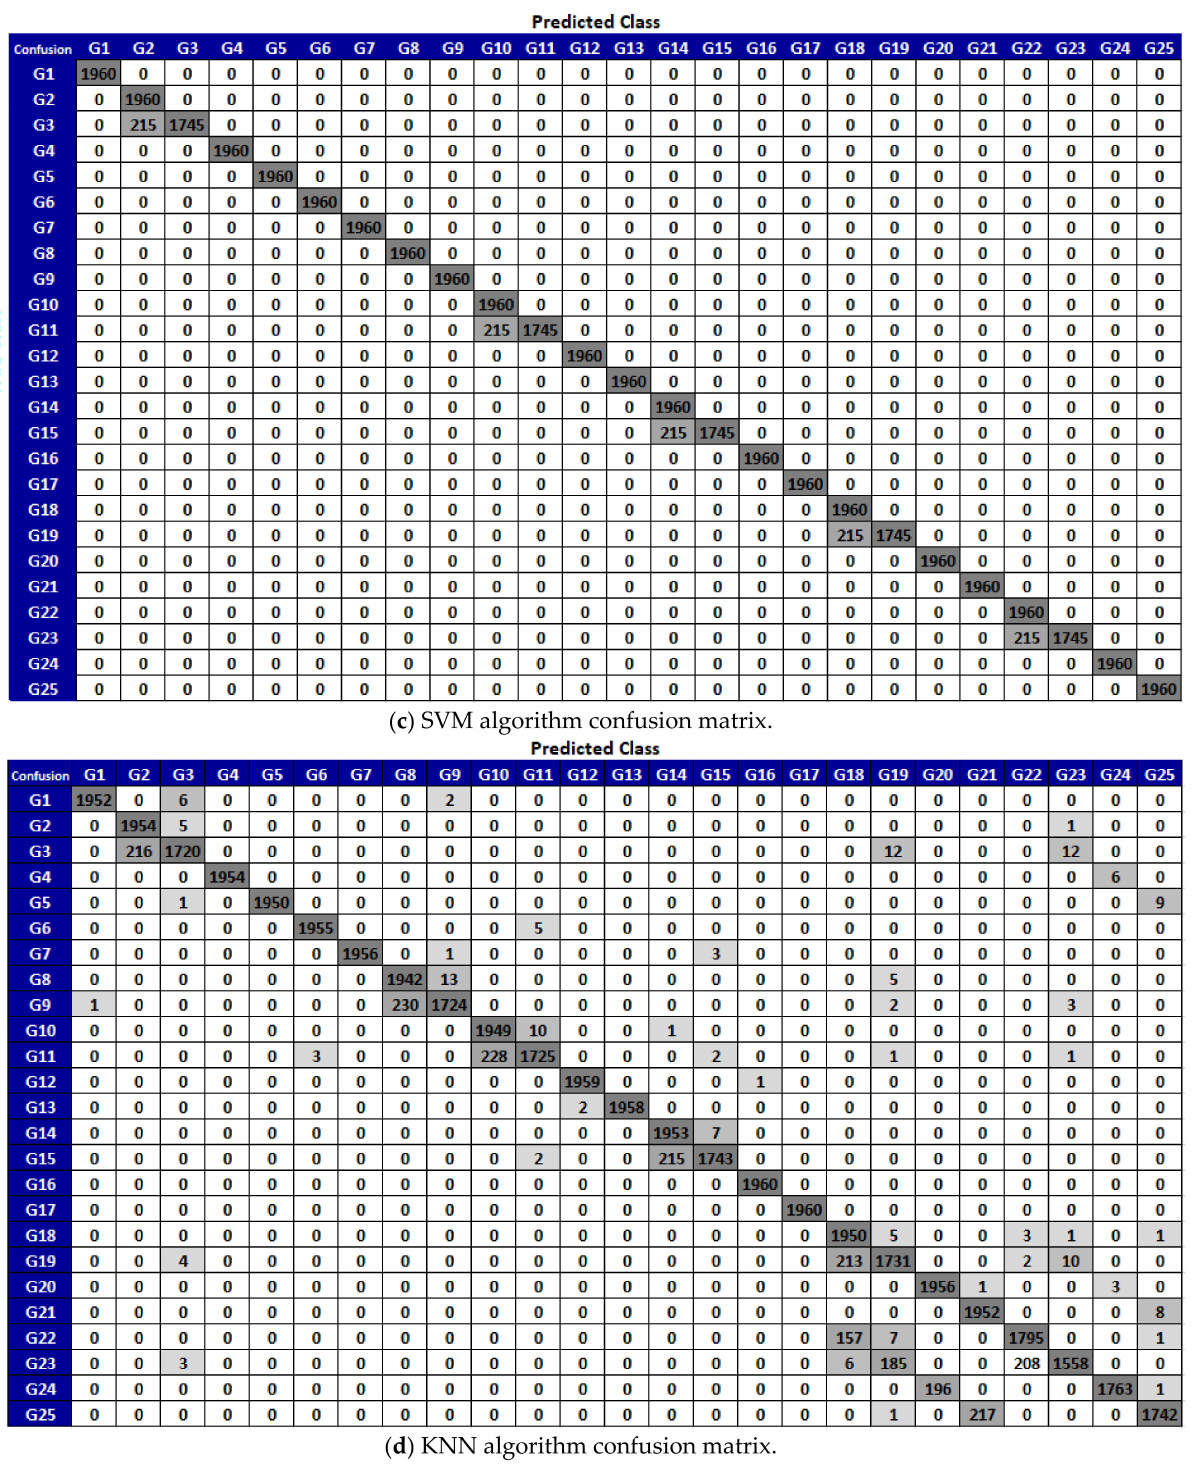
Figure 7. Confusion matrices obtained by operating the ( a ) DT confusion matrix, ( b ) NB confusion matrix, ( c ) SVM confusion matrix, and ( d ) KNN confusion matrix, classification algorithms used to describe the 25 different